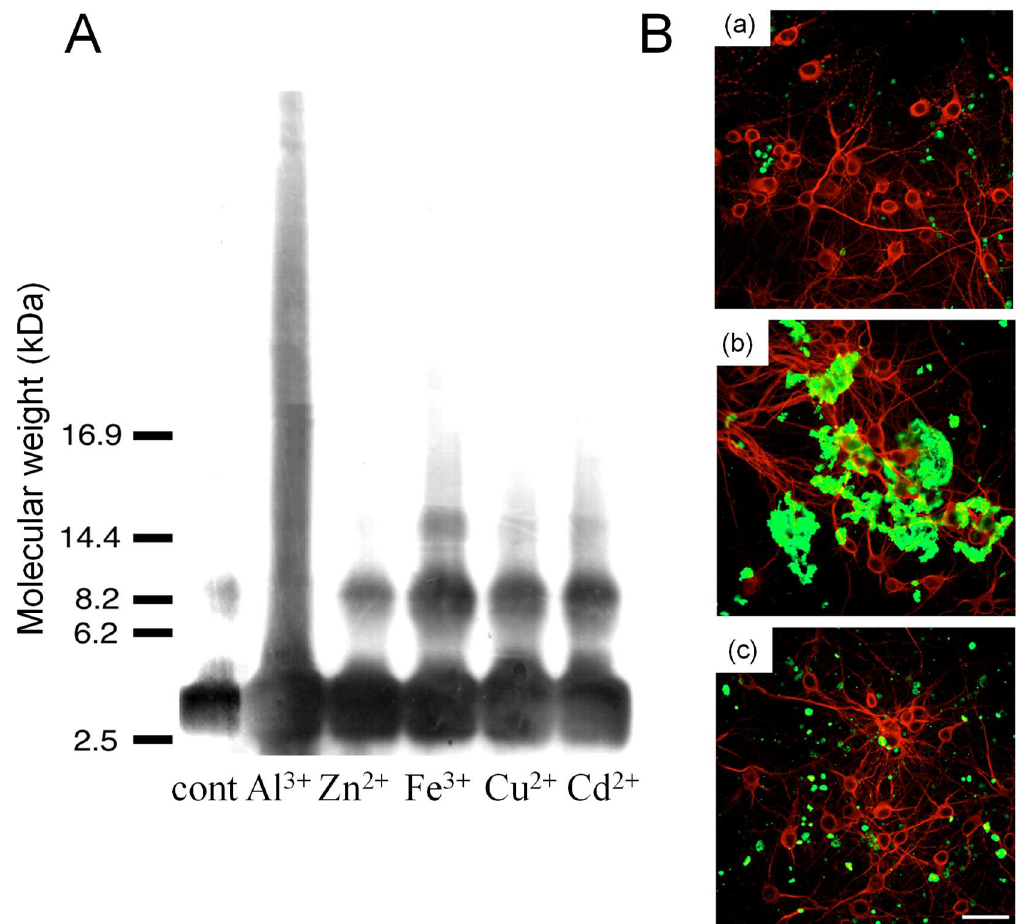
Figure 4. Metal-induced aggregation of AβP 1–40 . ( A ) Aggregation of AβP 1–40 by various metals. The solutions of AβP 1–40 were incubated at 37 °C for 24 h with or without various metal ions (each 1 mM), and were separated by SDS-PAGE using the tris-tricine method. (From [8], used with permission). ( B ) Deposition of AβP 1–40 oligomers on neuronal membranes. The solutions of AβP 1–40 were incubated at 37 °C for 24 h with Al 3+ or Zn 2+ , and were applied onto cultured cortical neurons. After two days of exposure, cells were washed and double-immunostained with a polyclonal antibody to AβP (green) and a monoclonal antibody to MAP2 (red). The cells were observed under a confocal laser scanning microscopy. ( a ) Control, ( b ) Al-aggregated AβP, ( c ) Al-aggregated AβP. Bar represents 50 µm. (From [9], used with permission).